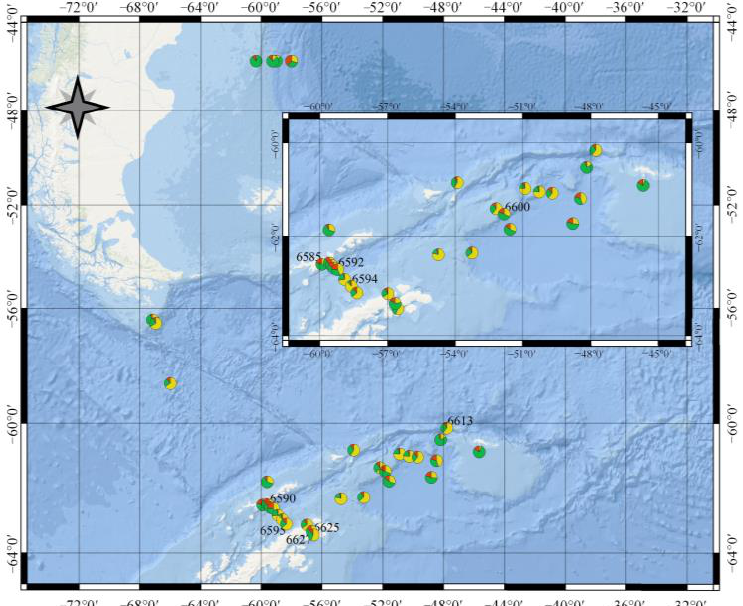
Figure 14. Contribution of the phytoplankton (green), non-algal particles (brown), and coloured dissolved organic matter (yellow) to the total non-water absorption at 438 nm in the surface layer of the Southern Ocean from 11 January – 4 February 2020.